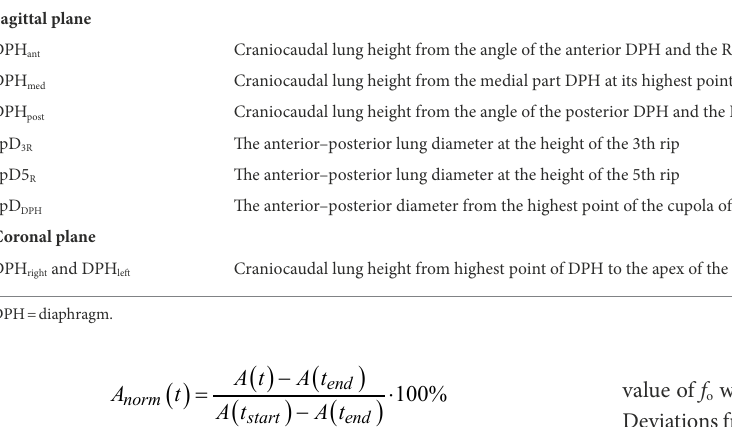
TABLE 3 Anatomical definition of distances in sagittal and coronal